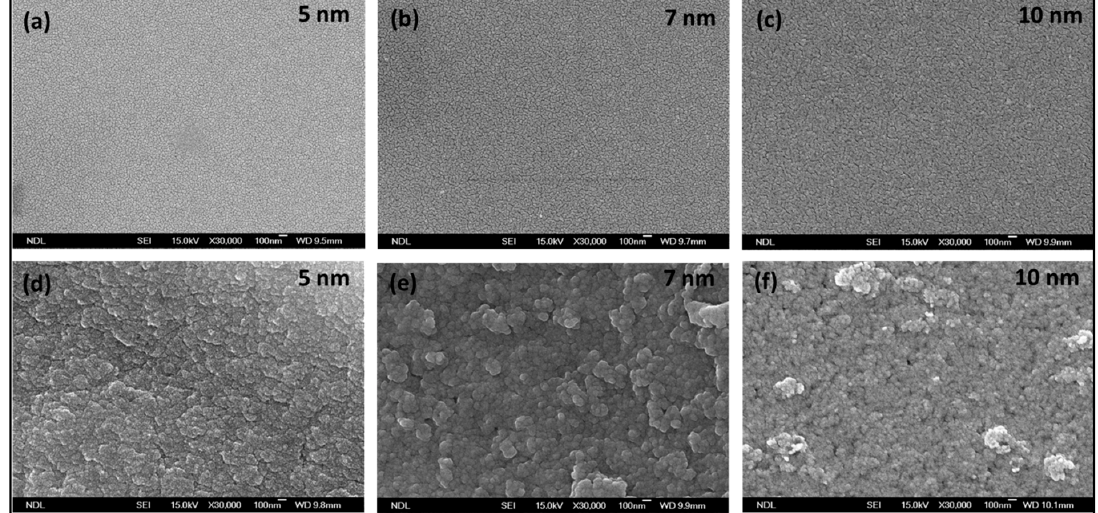
Figure 2. SEM images of Si–Au thin films of ( a ) 5 nm, ( b ) 7 nm, and ( c ) 10 nm; and PSi–Au thin films of ( d ) 5 nm, ( e ) 7 nm, and ( f ) 10 nm.